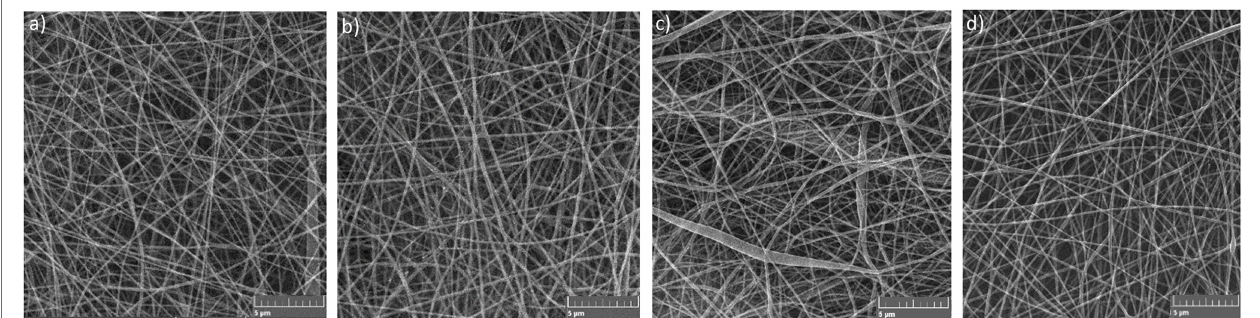
FIGURE 3 | SEM images of (a) PA, (b) PA/NAT, (c) PA/RE, and (d) PA/GTE